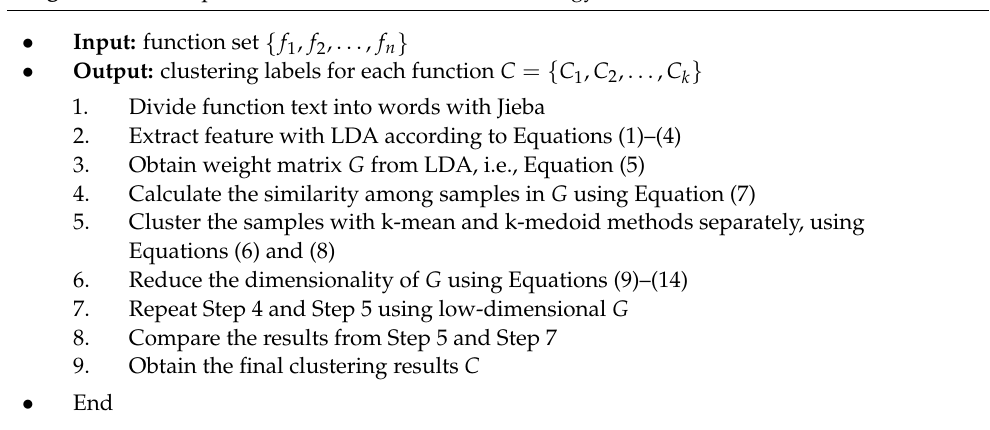
Algorithm 1: The pseudo-code of the whole methodology